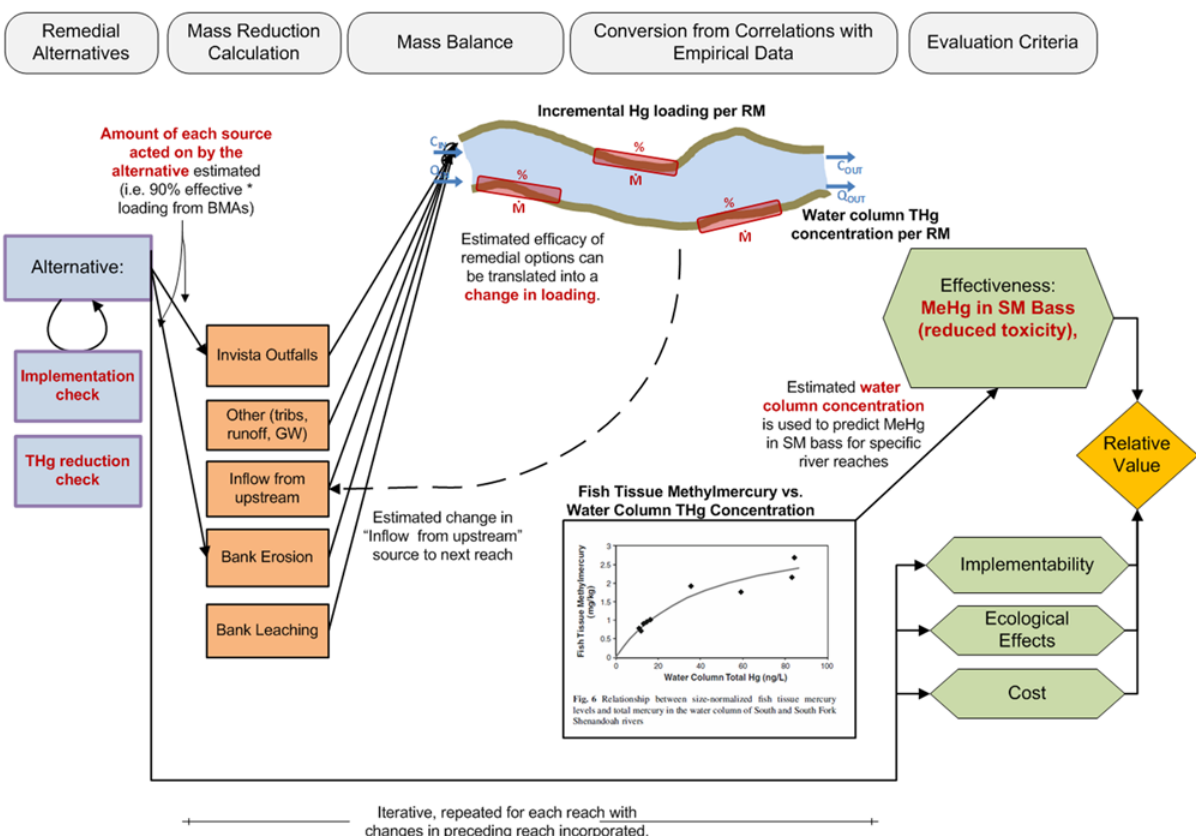
Figure 1. The decision model utilized in the EAM approach for remediation of legacy Hg in the South River. The remedial alternatives need to be specified in terms of their efficiency in reducing the THg loading rate expected in each compartment (orange boxes). This local efficiency in THg loading reduction together with initial river flow rates and water column THg concentrations are utilized in a mass-balance calculation (river schematic) which determines the anticipated change in water column THg loading and concentration in various specified river reaches. The new water column THg concentration is then compared to empirical data (inserted graph) to predict of the smallmouth bass tissue MeHg concentration anticipated at steady state after implementation. The effectiveness of the remedial alternative, as indicated by the anticipated reduction in smallmouth bass MeHg, is combined with the implementability, ecological effects and estimated cost of that alternative to calculate the relative value associated with that specific remedial approach.